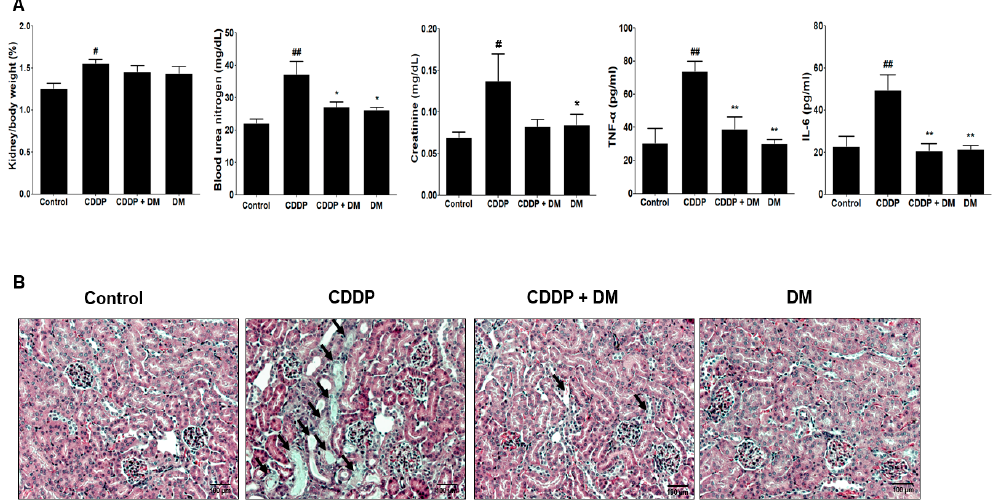
Figure 9. Protective effect of DM on CDDP-induced nephrotoxicity in tumor xenograft mice transfected with HCT-116 cells. ( A ) Kidney weight, nephrotoxicity biomarkers, and inflammatory cytokine levels were measured in the serum of tumor-bearing mice treated with CDDP. Values are